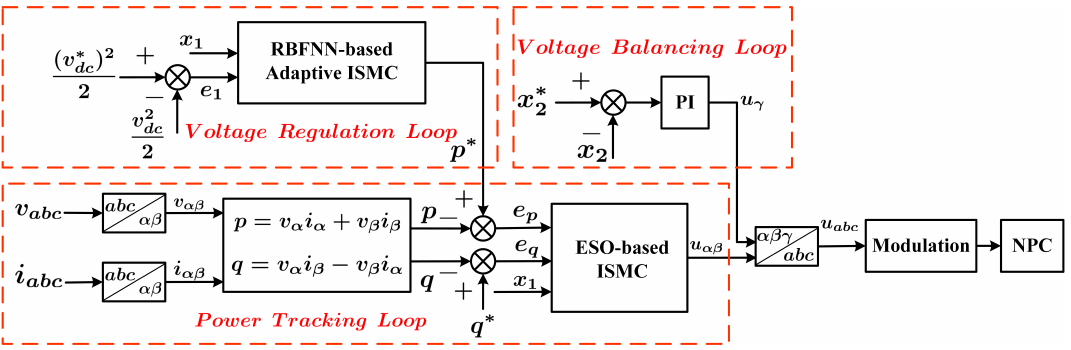
Figure 3. The control structure of the proposed